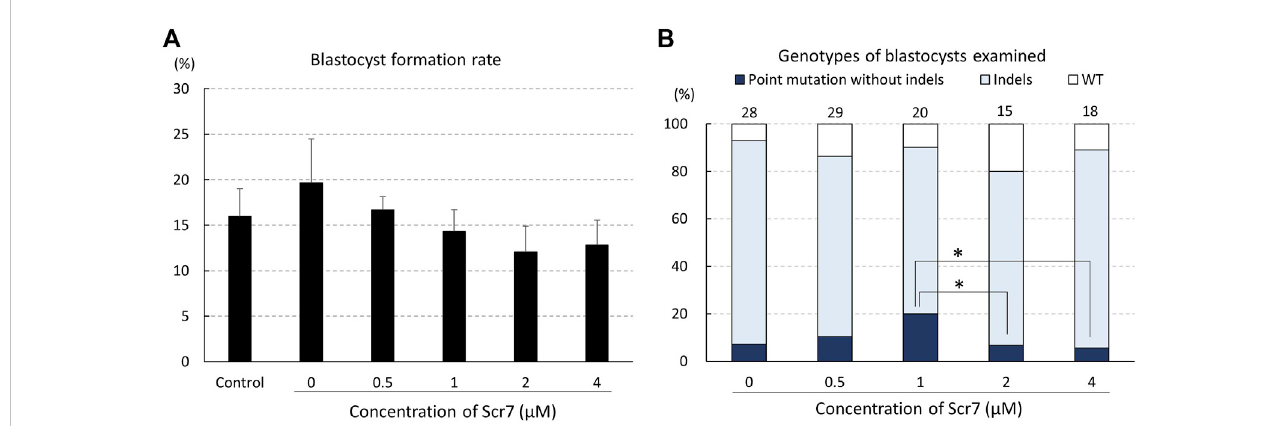
FIGURE 2 Rates of blastocyst formation (A) and genotypes of blastocysts (B) developed from zygotes electroporated with the CRISPR/Cas9 system targeting the INS gene and single-stranded oligodeoxynucleotide (ssODN) with various Scr7 concentrations. The percentage of point mutations and indels indicates the ratio of the number of blastocysts carrying a point mutation/indel to the total number of blastocysts examined. Five replicate trials were carried out, and numbers above the bars indicate total number of blastocysts examined. Point mutation without indels, blastocyst carrying a point mutation without another mutation; Indels, blastocyst carrying mutations around the gRNA-targeting site; WT, wild-type. Error bars indicate the mean ± SEM (A) . * p < .1.